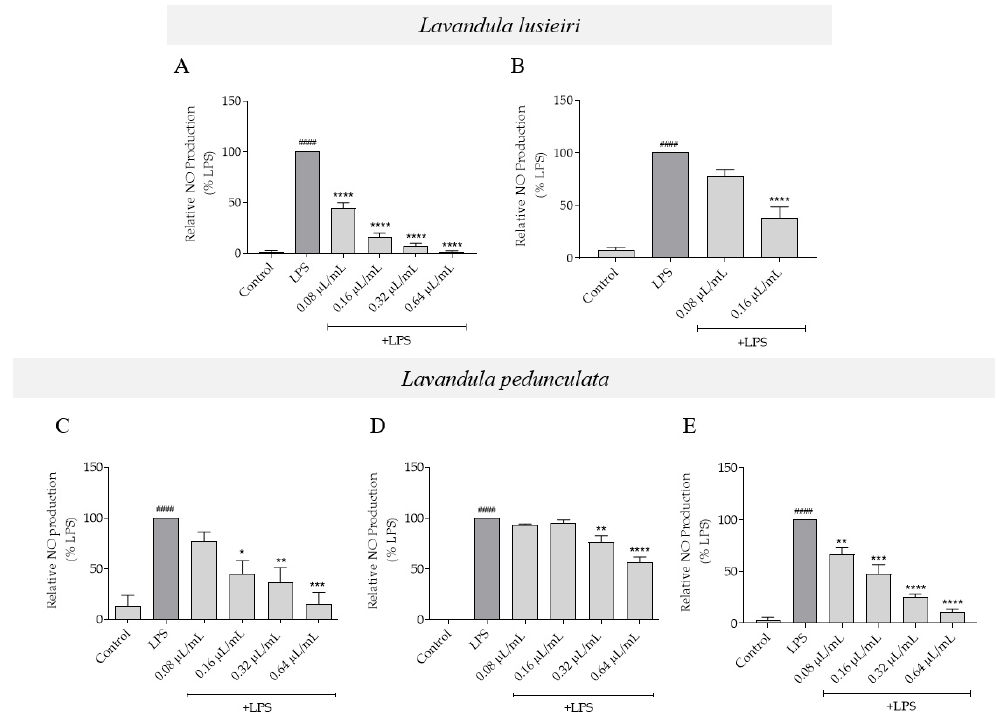
Figure 3. Inhibition of NO production by Lavandula spp. essential oils. Effect of L. luisieri essential oil with ( A ) low (sample A1) or ( B ) high (sample A2) amounts of necrodane derivatives and L. pedunculata rich in ( C ) 1,8-cineole (sample B1), ( D ) fenchone (sample B2) and ( E ) camphor (sample B3) on NO production induced by LPS in macrophages. Cells were maintained in culture medium (control), or incubated with 1 µ g/mL LPS, or with LPS in the presence of different concentrations of the oil (0.08–0.64 µ L/mL), for 24 h. Nitrite concentration was determined from a sodium nitrite standard curve and the results are expressed as a percentage of NO production by cells treated with LPS. Each value represents the mean ± SEM of three independent experiments, performed in duplicate (#### p < 0.0001, compared to control; * p < 0.05, ** p < 0.01 and *** p < 0.001 and **** p < 0.0001, compared to